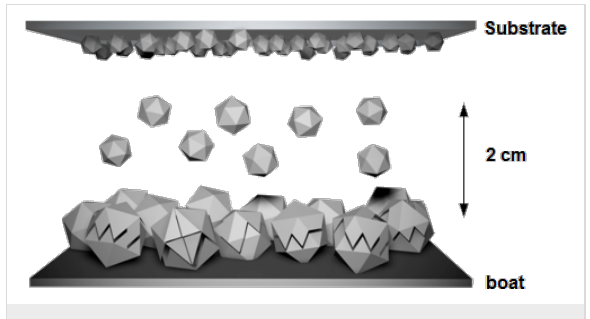
sition of the nanoparticles in ZnO–ZnO molecules, as was expected. The given nanoparticles of 30 nm in average size used as the source are decomposed into two or three smaller particles that migrate to the substrate. When this particle reaches the substrate, it lacks surface energy to be